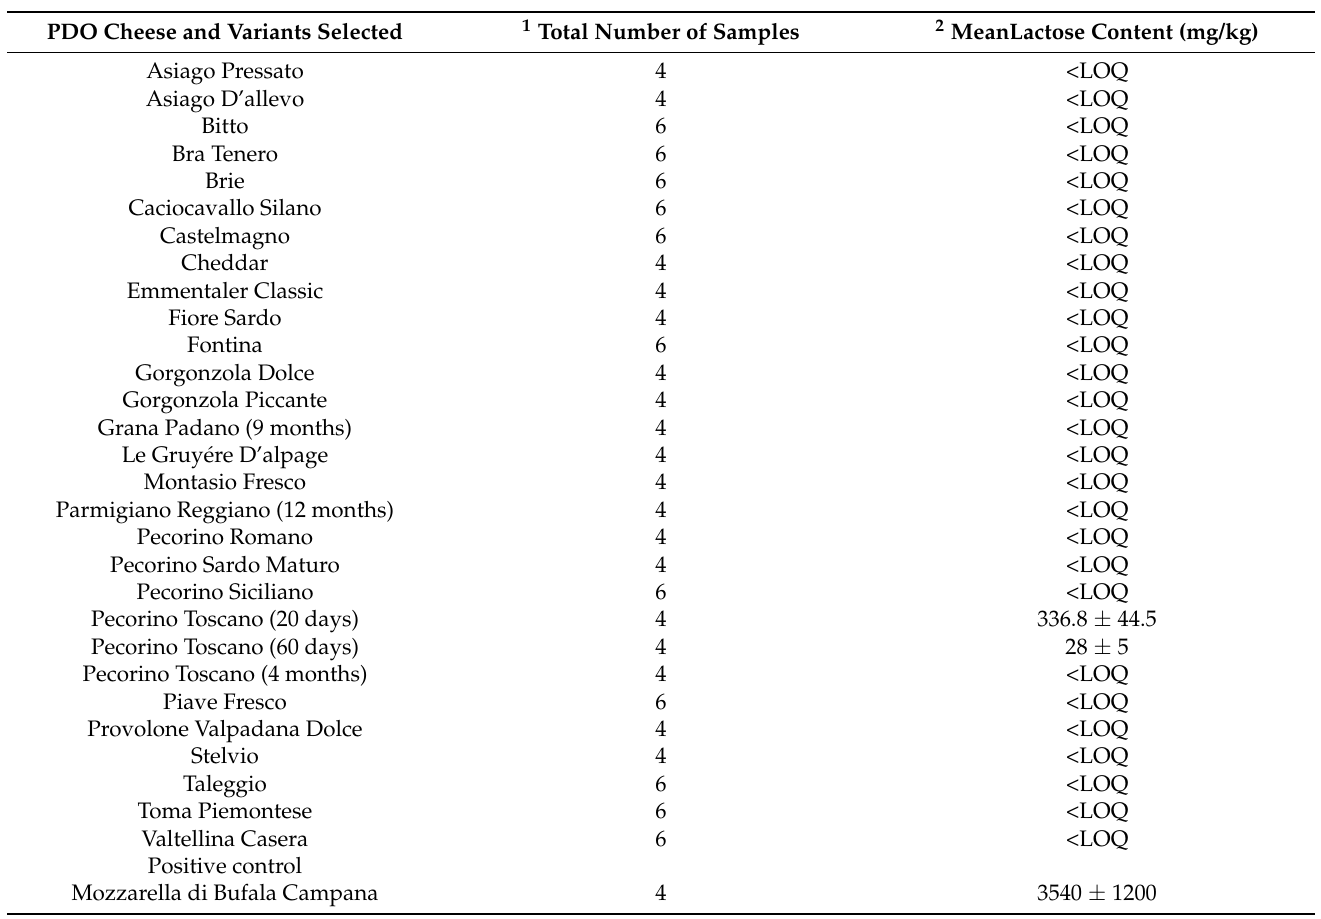
Table 6. Type of selected PDO cheeses and the results of the analyzed residual lactose content. The results were in agreement between the two analytical techniques used: HPAEC-PAD (Tentamus Agriparadigma Srl laboratory, Ravenna, Italy) and LC/MS-MS (Neotron Spa laboratory, Modena,